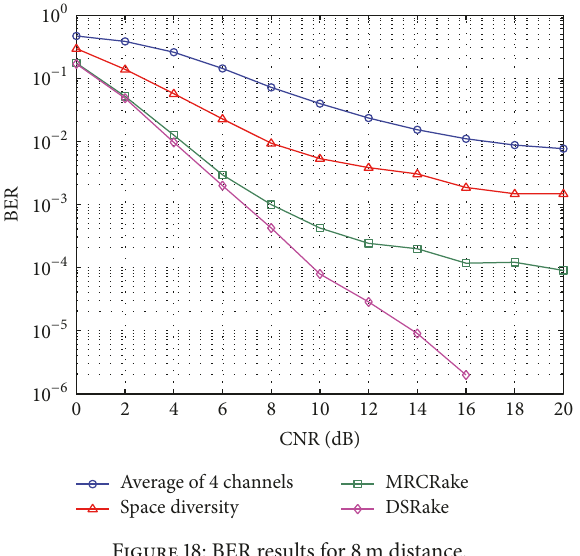
Figure 18: BER results for 8m distance.